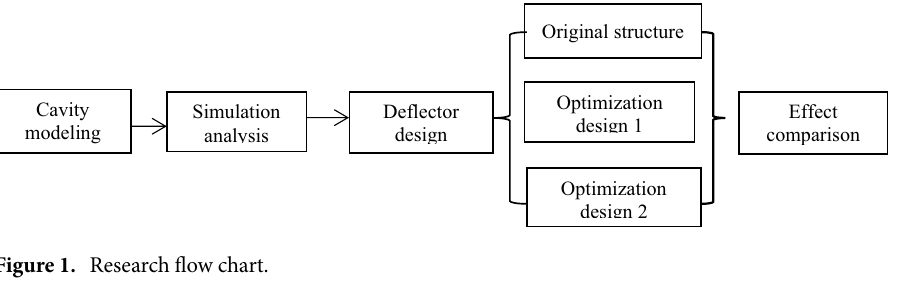
Figure 1. Research flow